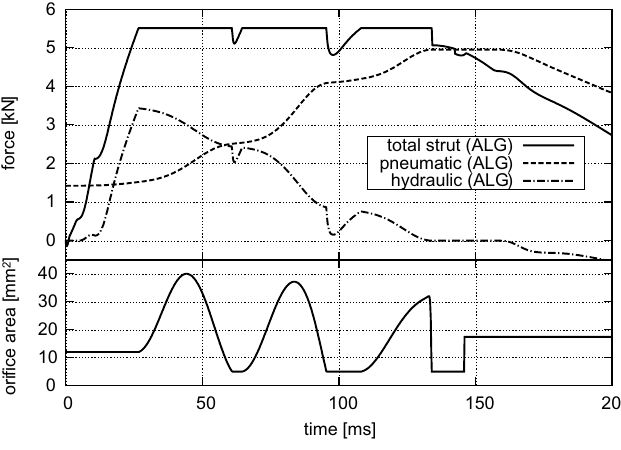
Fig. 13. Computed pneumatic, hydraulic and total strut forces in ALG, and active control for m = 350 kg and v 0 = 1 . 5 m / s